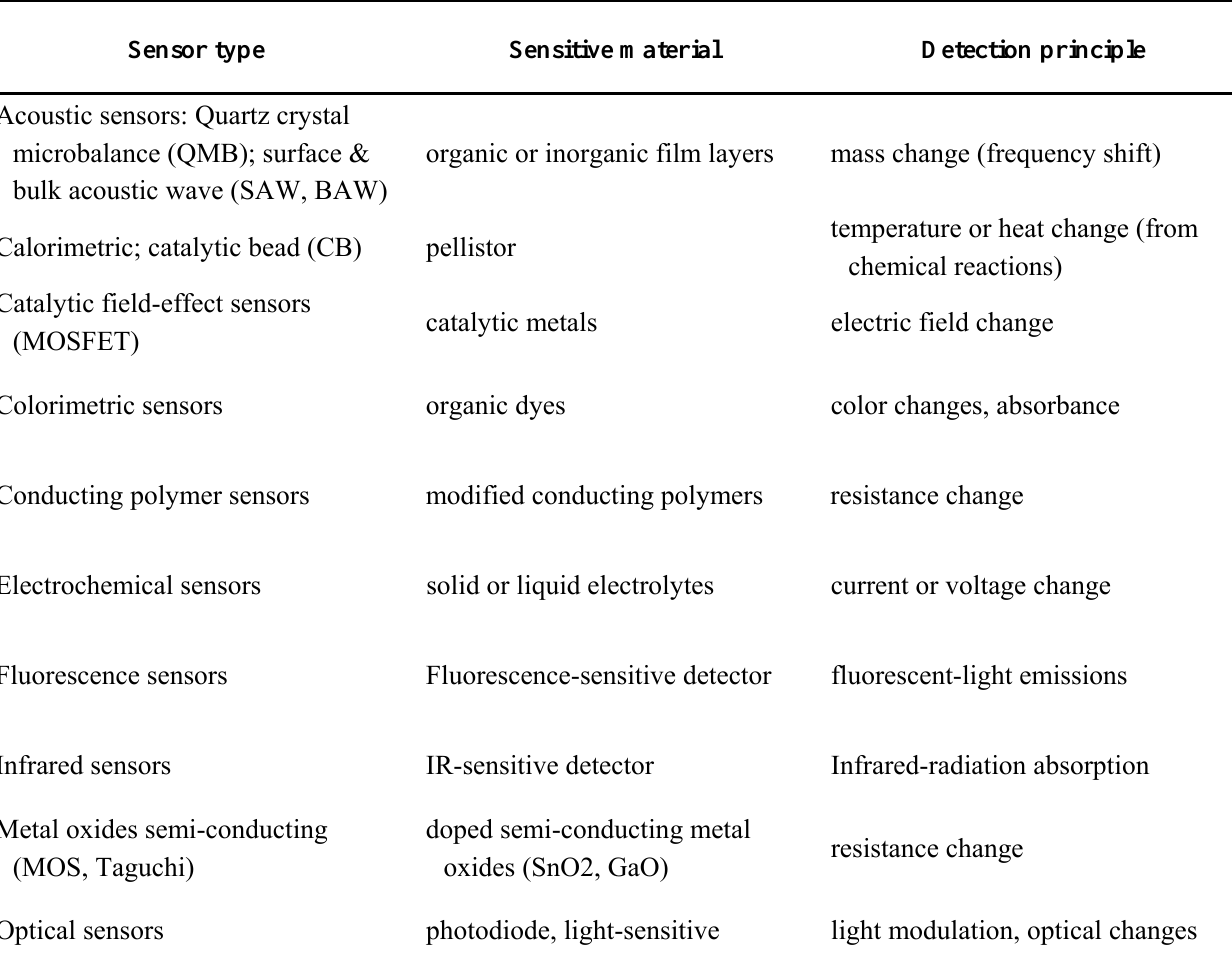
Table 3. Types and mechanisms of common electronic-nose gas